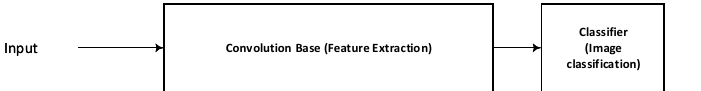
Figure 3. Basic structure of the convolutional neural networks (CNN) divided into two